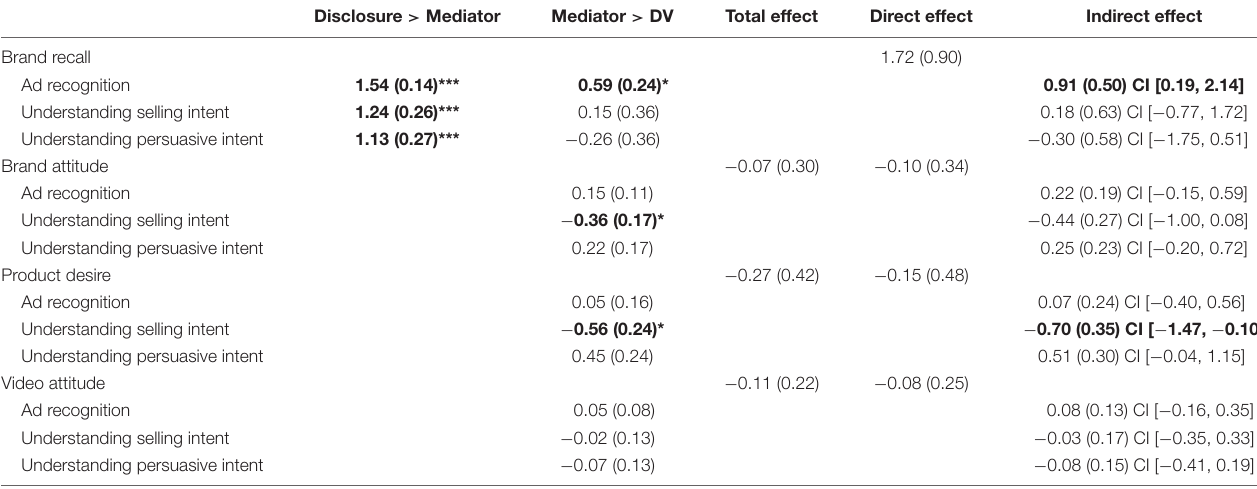
TABLE 2 | Mediation effects of the recalled disclosure (vs. no disclosure) on brand, product, and video responses via advertising